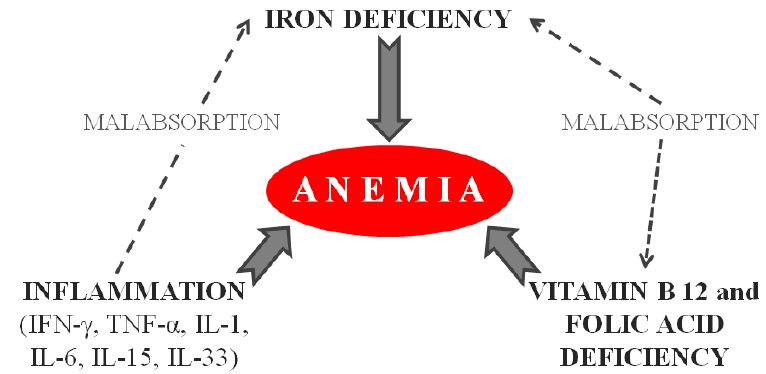
Figure 1. Main pathogenetic mechanisms of anemia associated with celiac disease.